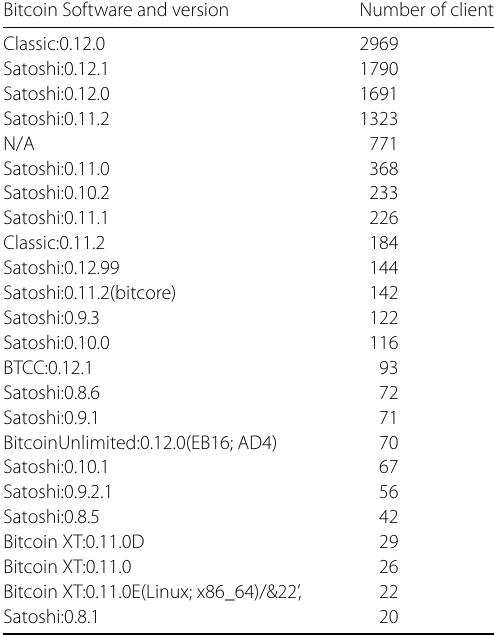
Table 2 Bitcoin Client Software used by 20 or more nodes Bitcoin Software and